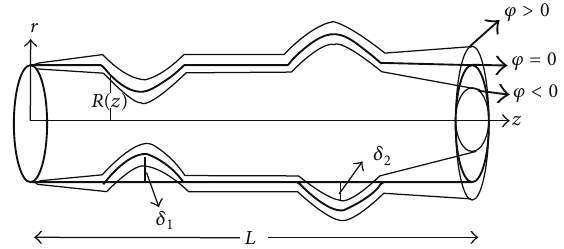
Figure 2: Geometry of the tapered artery with stenosis and dilata- tion for different taper